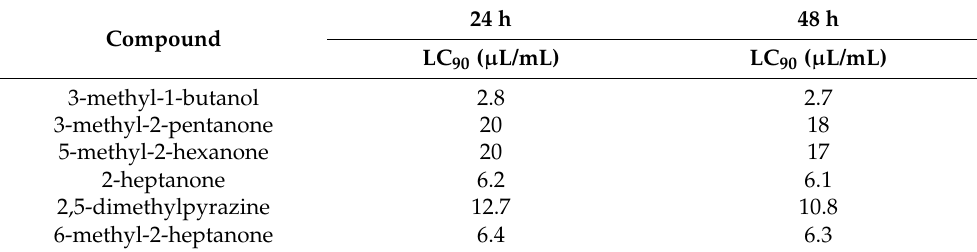
Table 2. Nematicidal activity of six commercial VOCs against second stage juveniles.